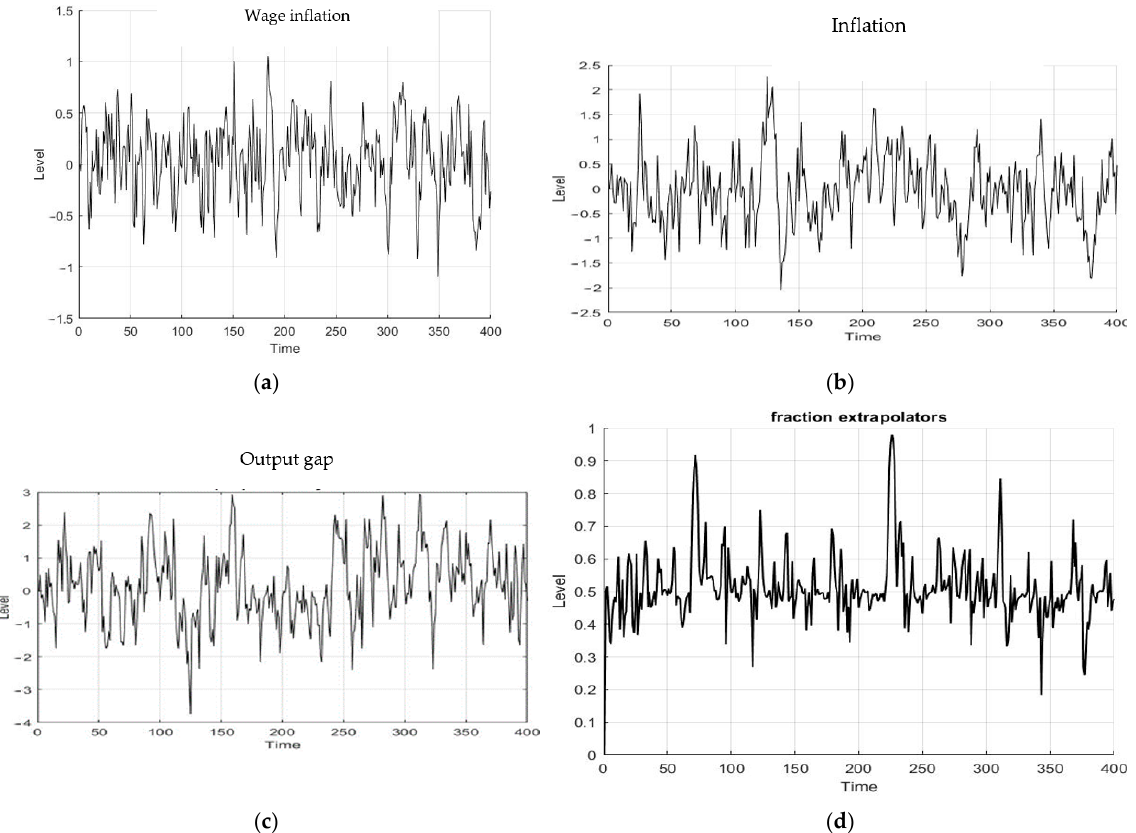
Figure 3. Schedules of cyclical movement: ( a ) wage inflation; ( b ) price inflation; ( c ) output gap; ( d ) shares of extrapolators in the studied behavioral model.